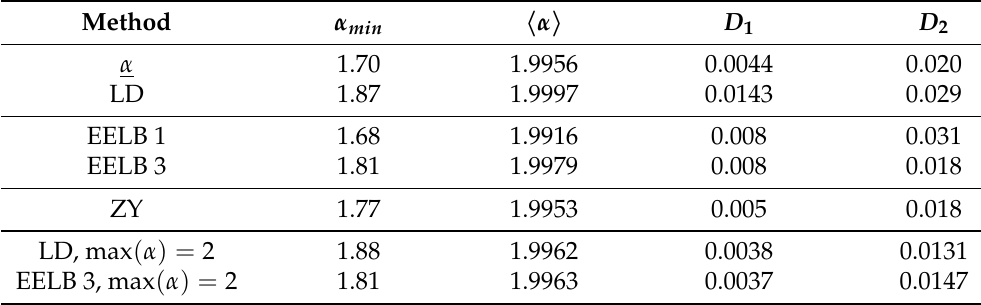
Table 1. Sod shock tube. The parameters α min , (cid:104) α (cid:105) , D 1 , D 2 defined by (23)–(25) are presented; α denotes the method based on Equation (16); LD is the low-dissipative entropic method described in the Proposition 1; EELB 1 is the first-order EELB method; EELB 3 is the third-order EELB method; ZY is the method of Zhao and Yong; LD, max ( α ) = 2 EELB 3, max ( α ) are the low-dissipative entropic and the third-order EELB methods for which α is bounded by